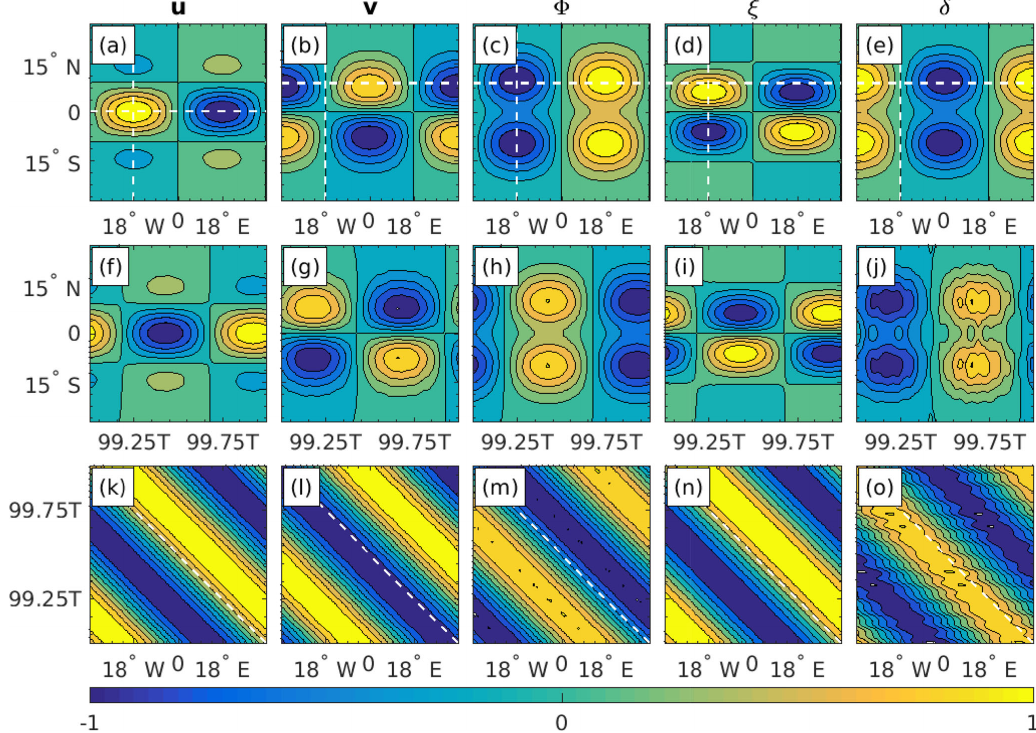
Figure 4. (a–e) The initial u , v , (cid:56) , ξ , and δ Rossby wave fields, obtained using the analytic expressions from Sect. 2 and the wave parameters from Sect. 3.1. (f–j) Latitude–time Hovmöller diagrams of the simulated solutions, obtained by intersecting the fields at λ = − 18 ◦ (also indicated by the white vertical dashed lines in a–e ). (k–o) Time–longitude Hovmöller diagrams of the simulated solutions, obtained by intersecting u at φ = 0 ◦ and all other fields at φ = 9 ◦ (also indicated by the white horizontal dashed lines in a–e ). The simulated solutions were obtained using GFDL’s global-scale spectral model. The fields are normalized on their global maximum at t = 0. The wave period for the chosen wave parameters is T = 18 . 5d. Contour levels range from − 1 . 0 to + 1 . 0 in intervals of 0 .